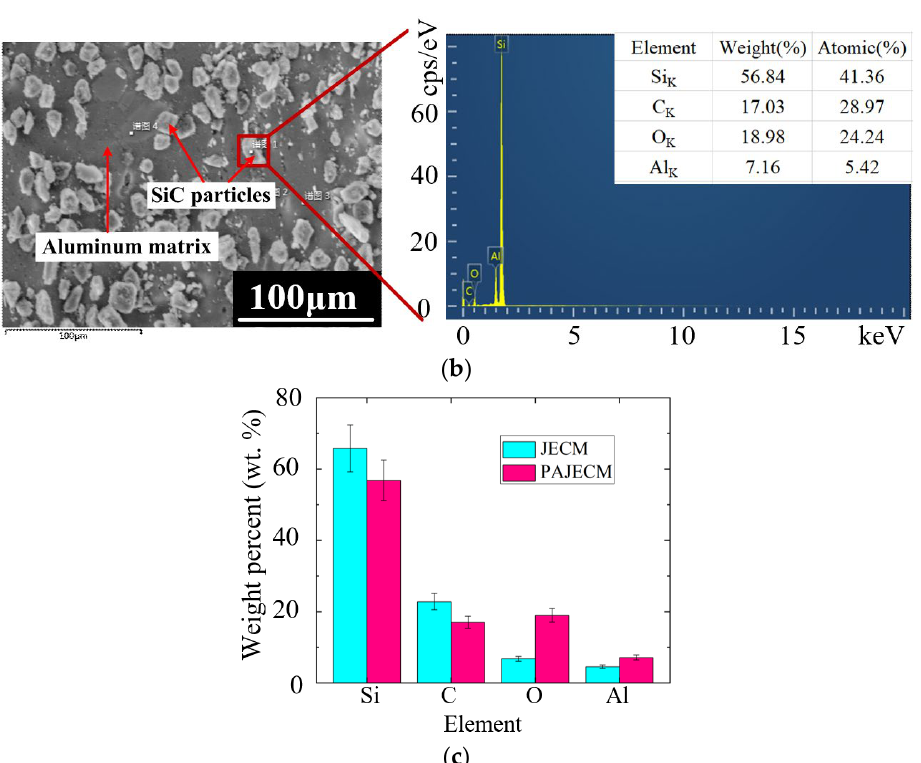
Figure 11. Atomic mass percentage of EDS point scan analysis of the machined surface at a voltage of 40 V: ( a ) JECM; ( b ) PAJECM; ( c ) element weight percentage comparison.